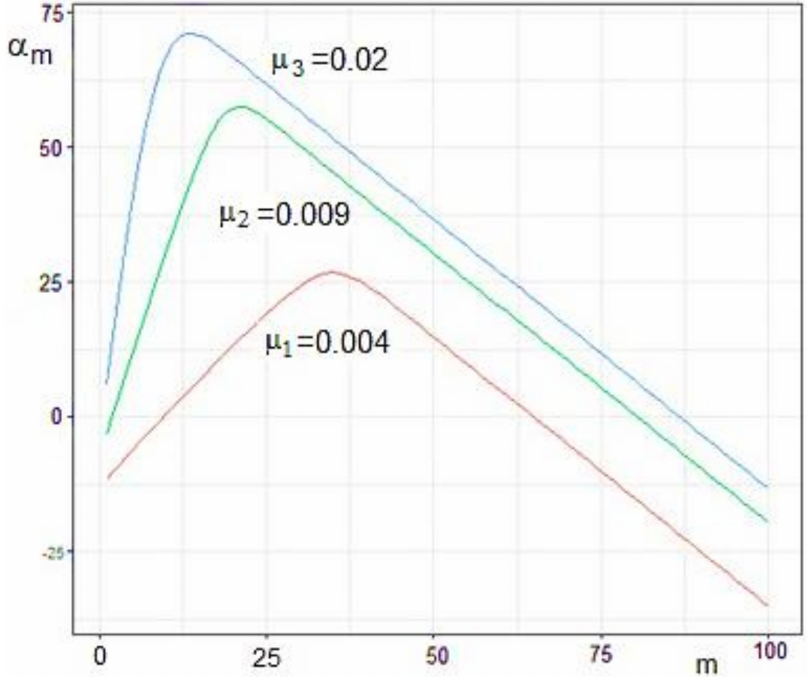
Figure 7. Simulation of the average gains α m for various numbers of m vehicles for the following data: µ 1 = 0.004, µ 2 = 0.009, and µ 3 = 0.02 and λ = 0.002. The OY axis represents Average